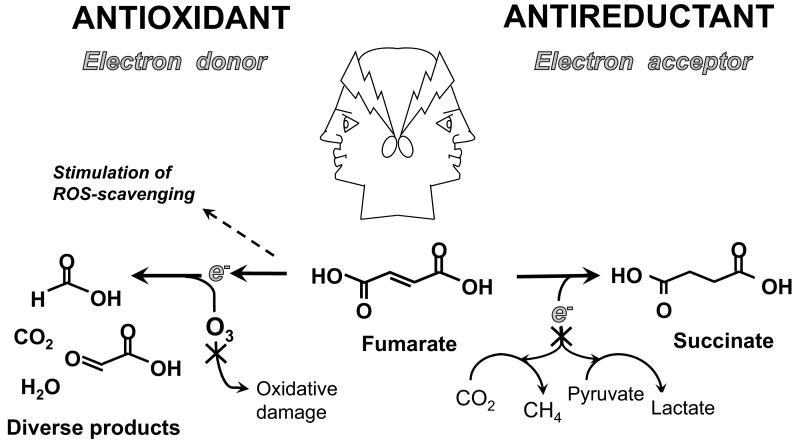
Janus-faced compound fumarate: both antioxidant and antireductant in one moleculeSources of data: [40,74,83,84].